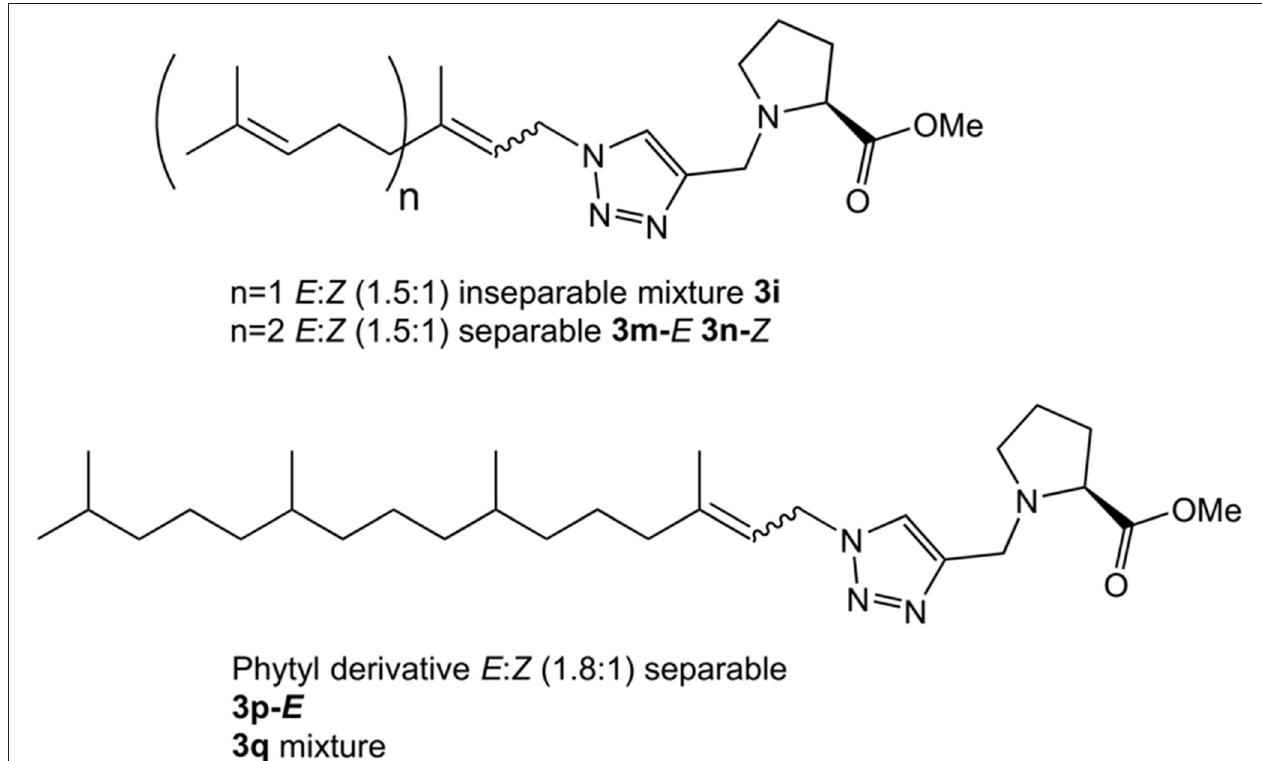
FIGURE 3 | Prenyl analogs